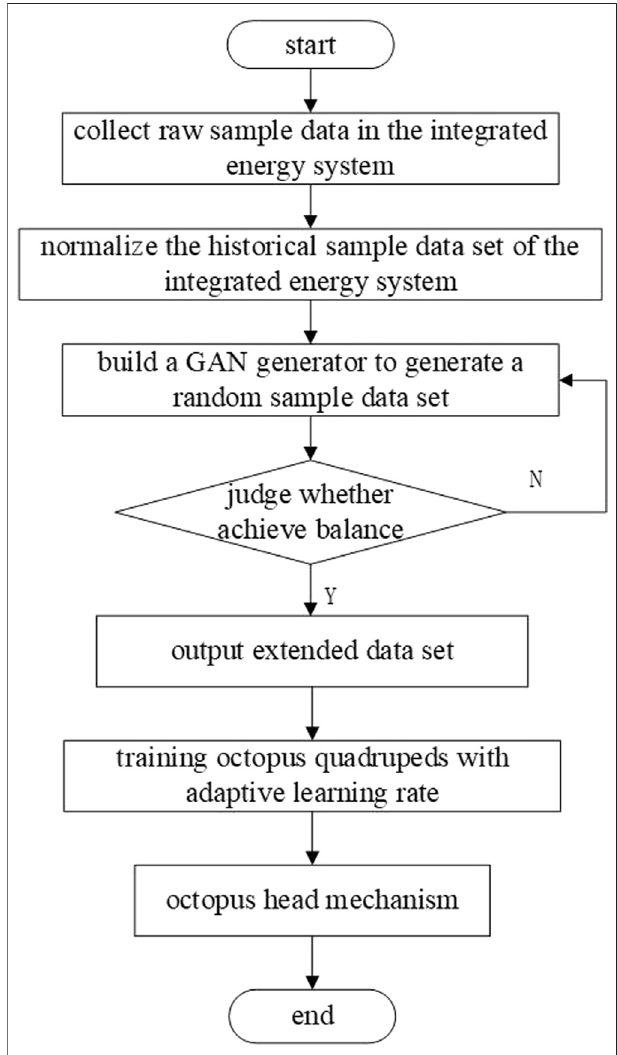
FIGURE 1 | Block diagram of the octopus model adaptive IES load forecasting